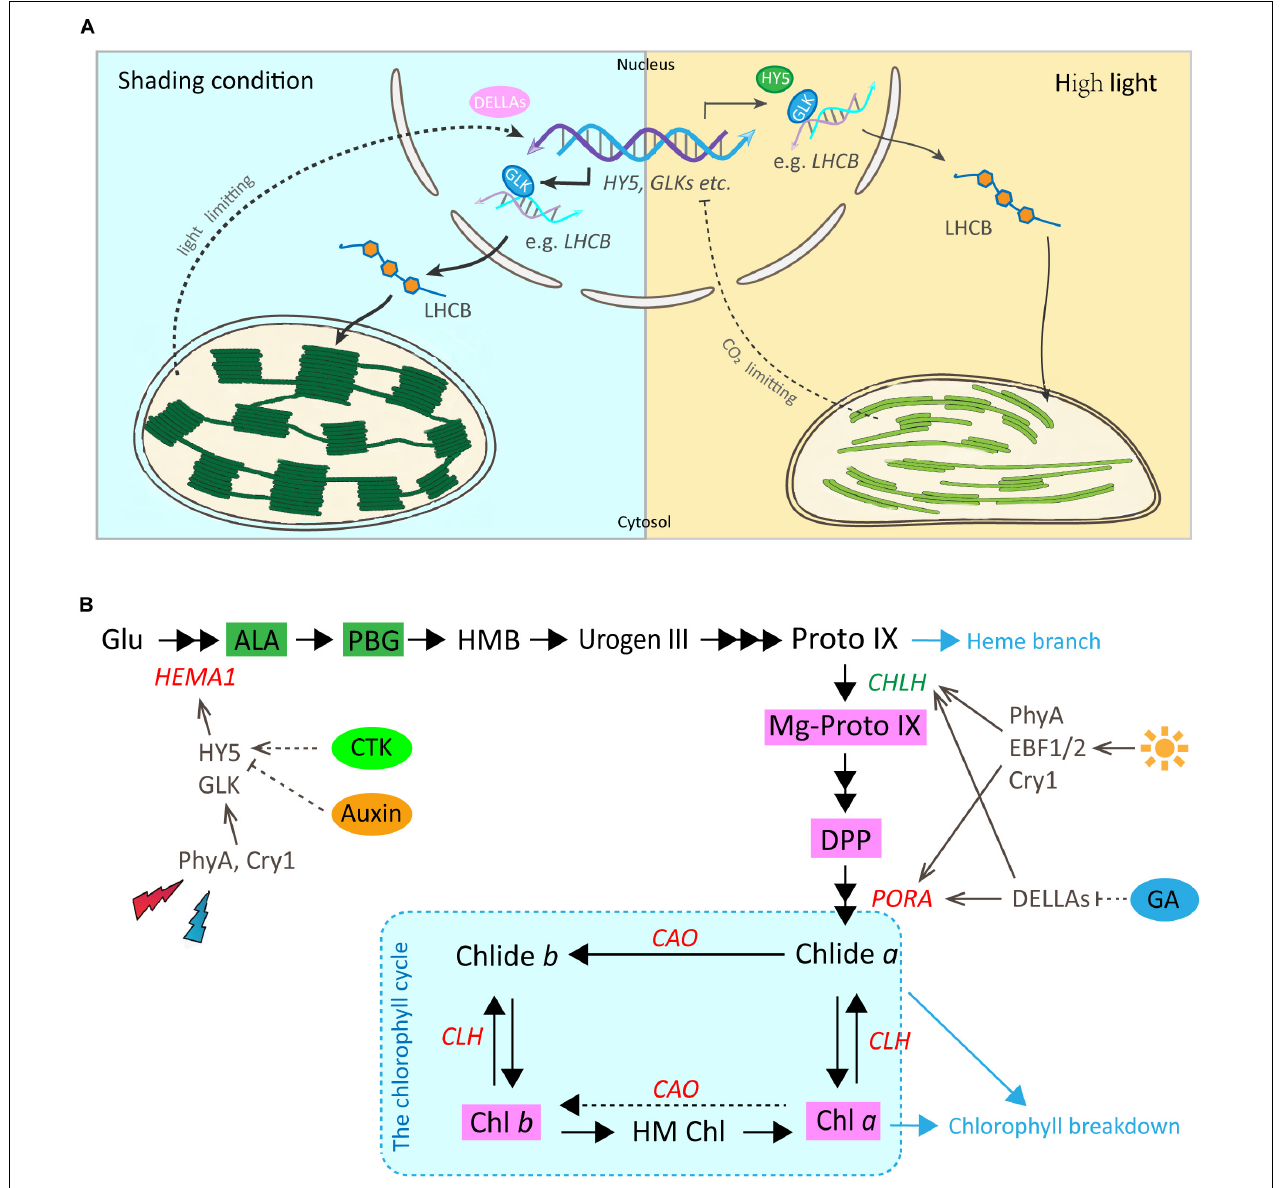
FIGURE 7 | Working models for the regulatory roles of light and hormones in chloroplast development and chlorophyll biosynthesis in Shuchazao leaves . (A) A predicted model for the regulatory role of light on chloroplast development by the GLK and other potential TFs in tea leaves (reproduced, in part, with permission from Waters and Langdale, 2009). Under the shade environment, the photosynthetic electron transfer chain is in an oxidized state and cannot provide sufficient ATP. Therefore, a light-limitation signal from the chloroplast is sent to the nucleus and GLK genes are up-regulated. Transcript levels of these GLK target genes increase leading to higher levels of proteins that function in light-harvesting (such as LHCB, etc.), and, therefore, assembly leads to higher specific chlorophyll levels, a lower Chl a / b ratio and more abundant grana. In contrast, when light is plentiful and the rate of CO 2 fixation is insufficient, this prompts a chloroplast-derived CO 2 fixation limiting signal to the nucleus. The transcriptions of GLK genes are repressed and the accompanying decrease in LHCB and chlorophyll-related gene transcripts, eventually results in a reduction in the thylakoid membrane and lower chlorophyll content. (B) A simplified regulatory network of chlorophyll biosynthesis by light and plant hormones in tea leaves (Red, increase in response to shade; Green, decrease in response to shade). The dashed portion indicates that further verifications are needed. For abbreviations, see